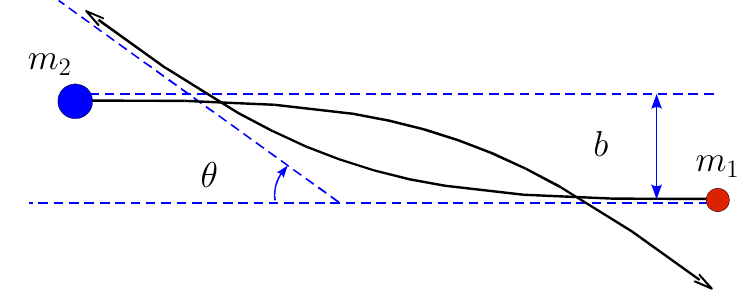
Fig. 13 Deflection angle θ of a “test” star of mass m 1 with a field star of mass m